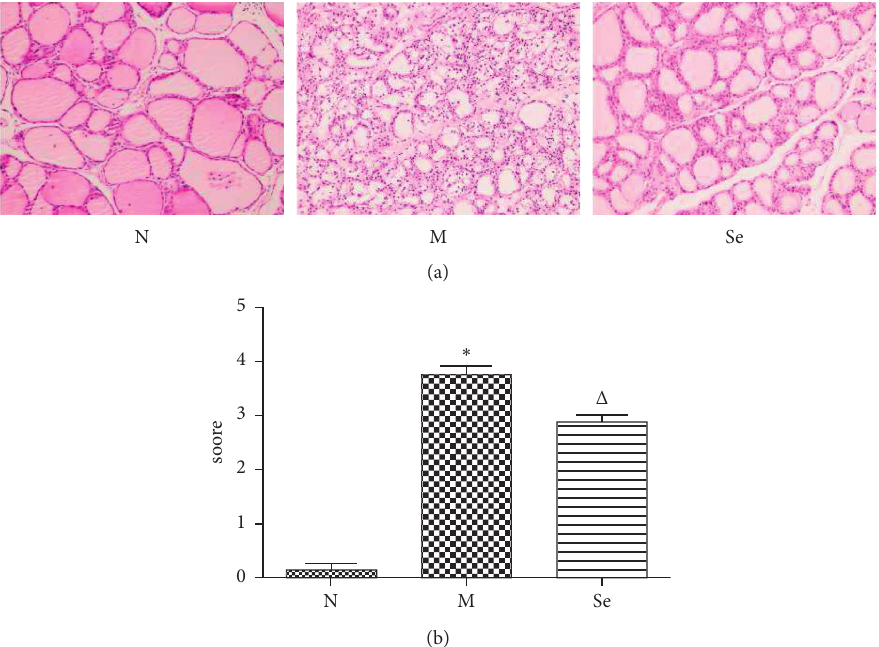
Figure 2: (a) Representative histographs of H&E-stained thyroid sections. (b) Thyroid histopathology scores. ∗ P < 0 . 05 compared to the N group. △ P < 0 . 05 compared to the M group (at 200 ×